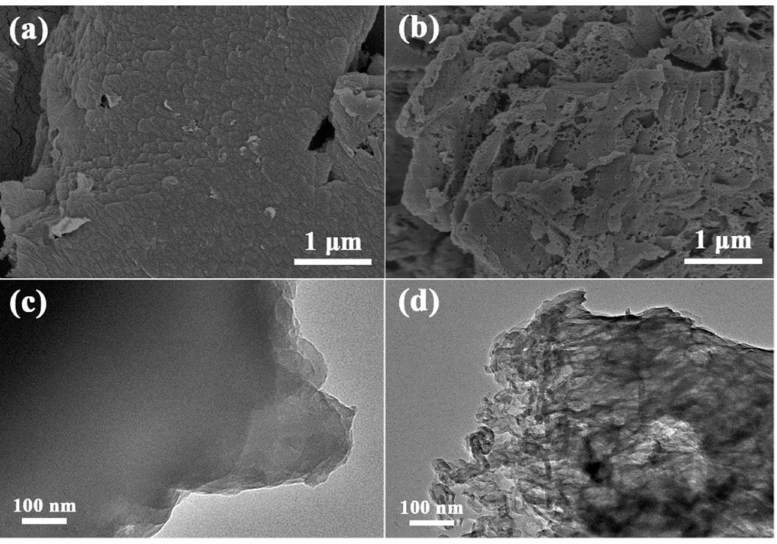
Figure 2. SEM and TEM images of ( a , c ) g-C 3 N 4 and ( b , d ) F-g-CN synthesized at 150 ◦ C. The XRD patterns of g-C 3 N 4 and F-g-CN in Figure 3a display a similar crystalline structure. The main diffraction peaks at 13.1 ◦ and 27.3 ◦ for all the samples correspond to the in-plane repetition of the tri-s-triazine motif and the periodic stacking of conjugated aromatic structures, respectively [37]. Note that the diffraction peak at 13.1 ◦ for F-g-CN almost disappears, which demonstrates the overwhelmingly destructed in-plane structure